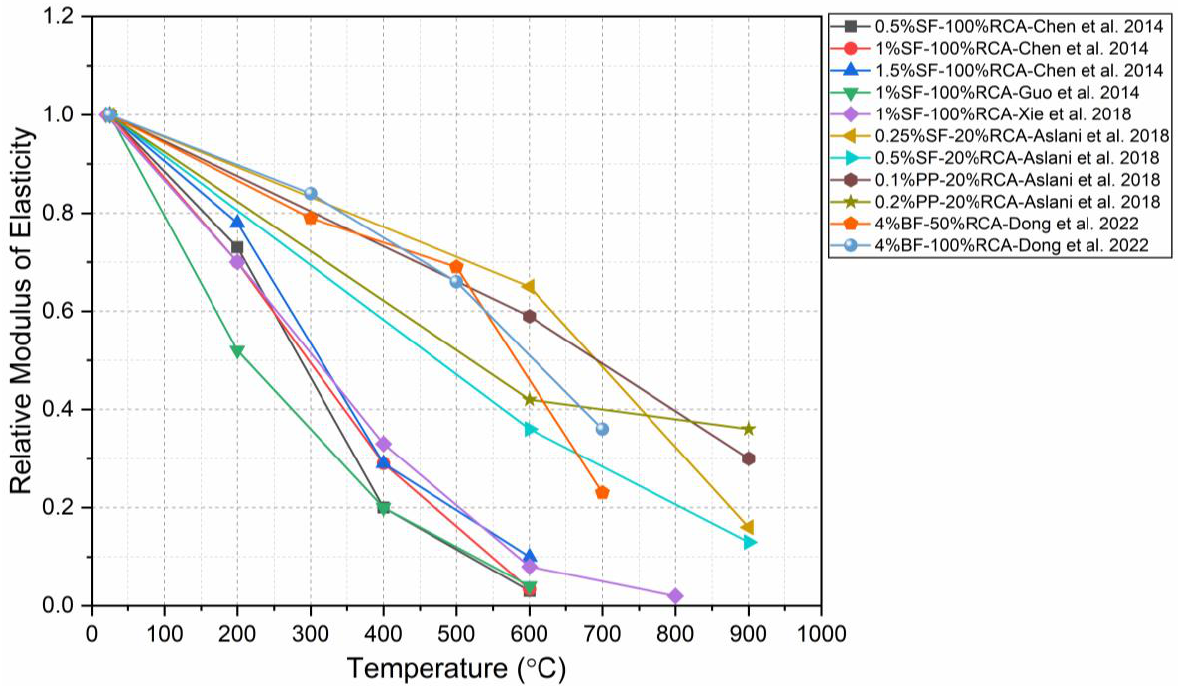
Figure 24. Influence of high temperatures and fiber dosages on the relative residual modulus of elasticity of FRAC [32,50,51,139,148].